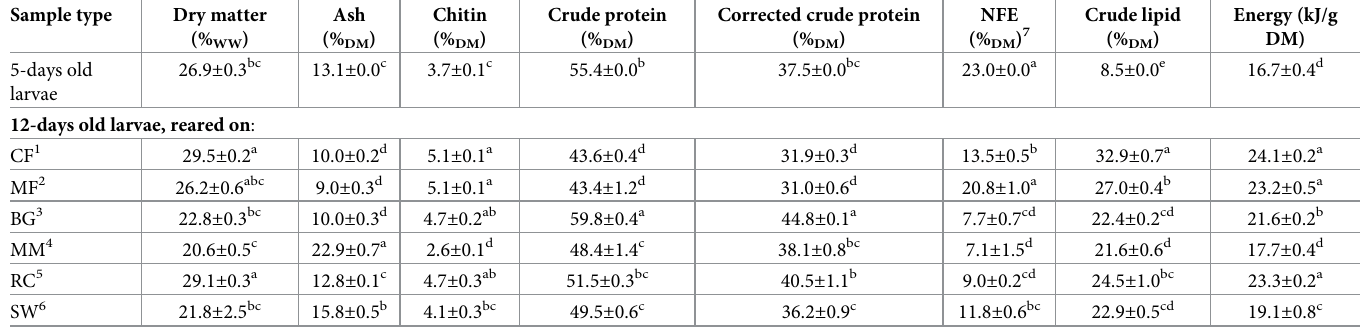
protein content was significantly highest in larvae fed brewer’s spent grain (59.8% DM) and lowest in those fed mixed feed and chicken feed (43.4–43.6% DM). However, the crude protein content, calculated using the standard Kp factor of 6.25, was 21–32% higher than the corrected crude protein content calculated using Kp factors based on the total amino acid content deter- mined in the larvae ( Table 4 ). Larval crude lipid ranged from 21.6 to 32.9% DM and was sig- nificantly different between several of the treatment groups, with the highest lipid content found in larvae fed chicken feed and the lowest content in larvae fed mitigation mussels. Chitin Table 1. Proximate composition of initial (5-days old) and final (12-days old) black soldier fly larvae reared on six different substrates (chicken feed (CF), mixed feed (MF), brewer’s spent grain (BG), mitigation mussels (MM), rapeseed cake (RC), and shrimp waste (SW)). All values are shown as mean ± standard error (SE; n = 3) for percentage of wet weight (% WW ), percentage of dry matter (% DM ), or kJ/g dry matter (DM). Corrected crude protein is calculated using the nitrogen-to-protein conversion factors described in Table 4 . Dissimilar lower case superscript letters represent significant differences between means within the same column (p < 0.05). Sample